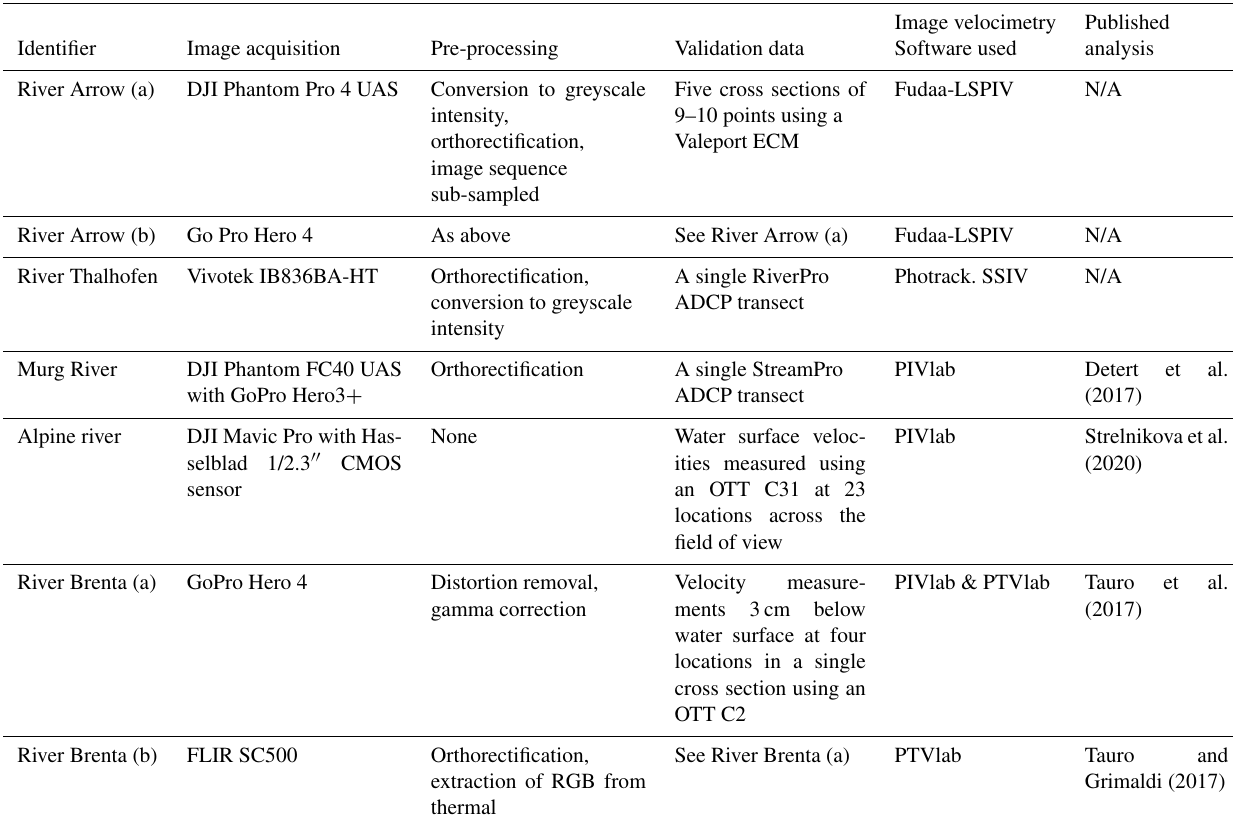
Table A2. Experimental setup during image acquisition, details of subsequent image pre-processing, availability of validation data, and published analysis. N/A is an abbreviation for “not